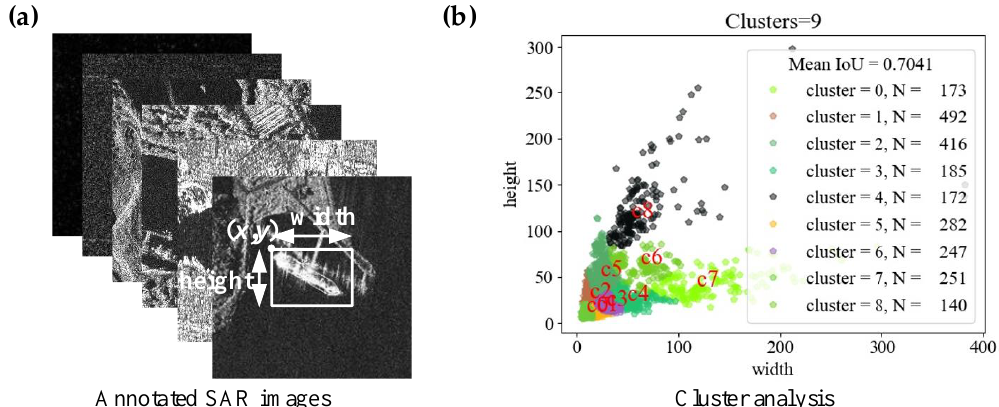
Figure 10. The results of K-means. ( a ) Annotated SAR images; ( b ) cluster analysis. Table 2. Anchor boxes of D-CNN-13, D-CNN-26, and D-CNN-56.